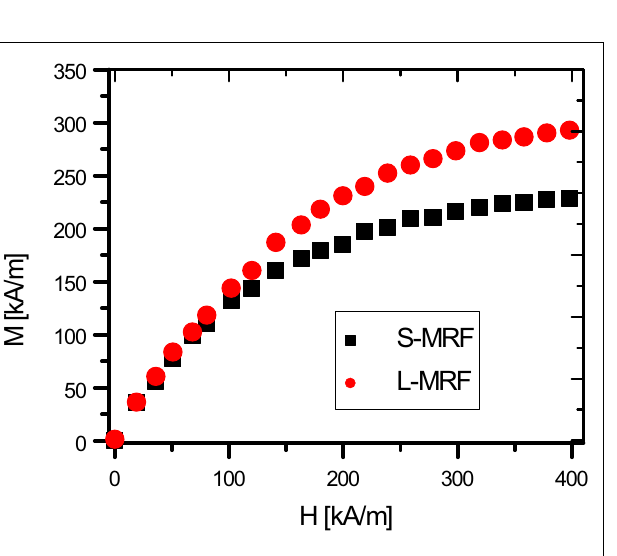
FIGURE 2 | Room temperature (300K) magnetization measurement of the S-MRF and L-MRF samples is shown